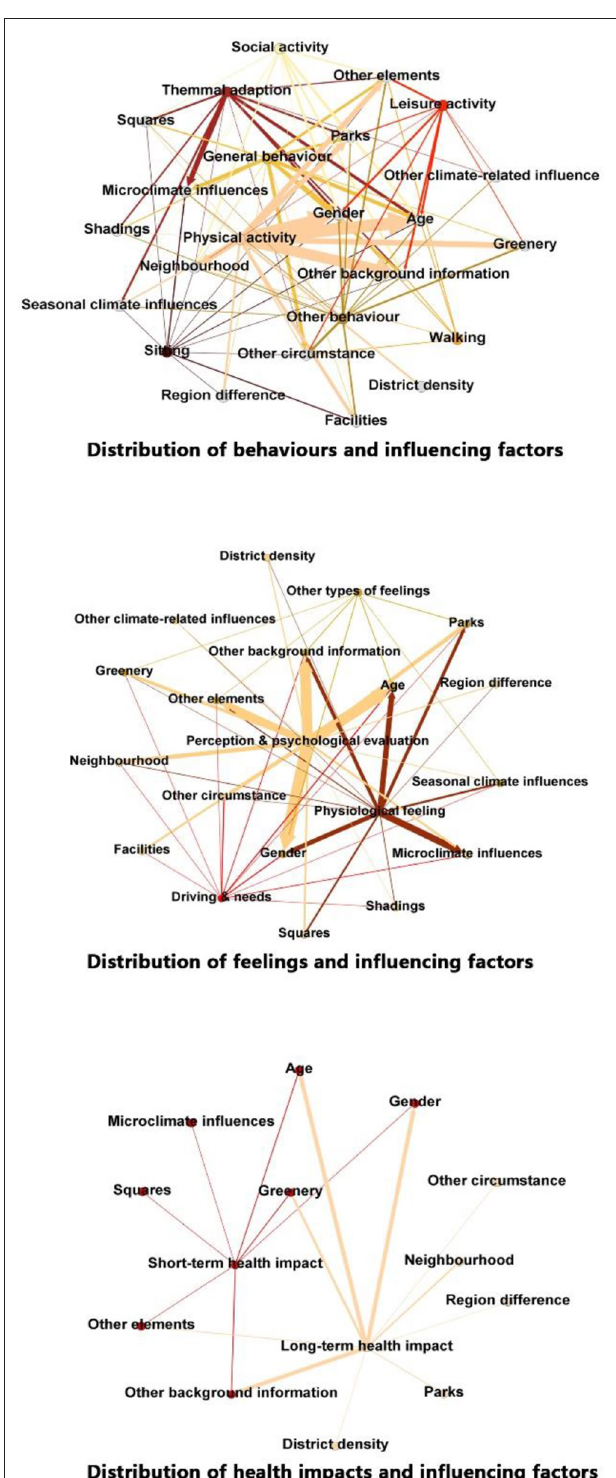
FIGURE 5 | Distribution of objective influencing